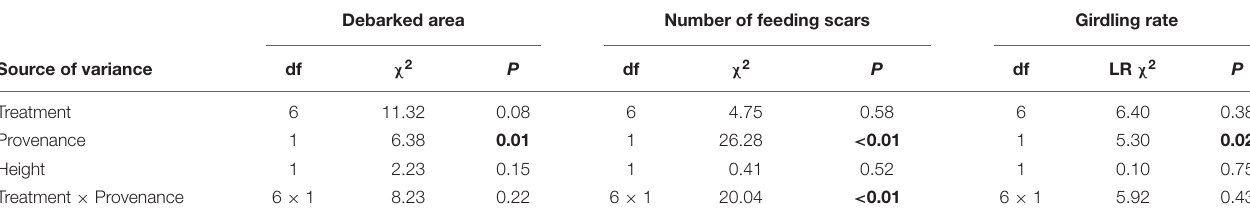
TABLE 1 | Results of analysis of deviance (df: degrees of freedom; χ 2 : Chi-square value; LR χ 2 : likelihood ratio Chi-square value; P : P value) from several models examining the effect of treatment on subsequent pine weevil damage in experiment 1. Debarked